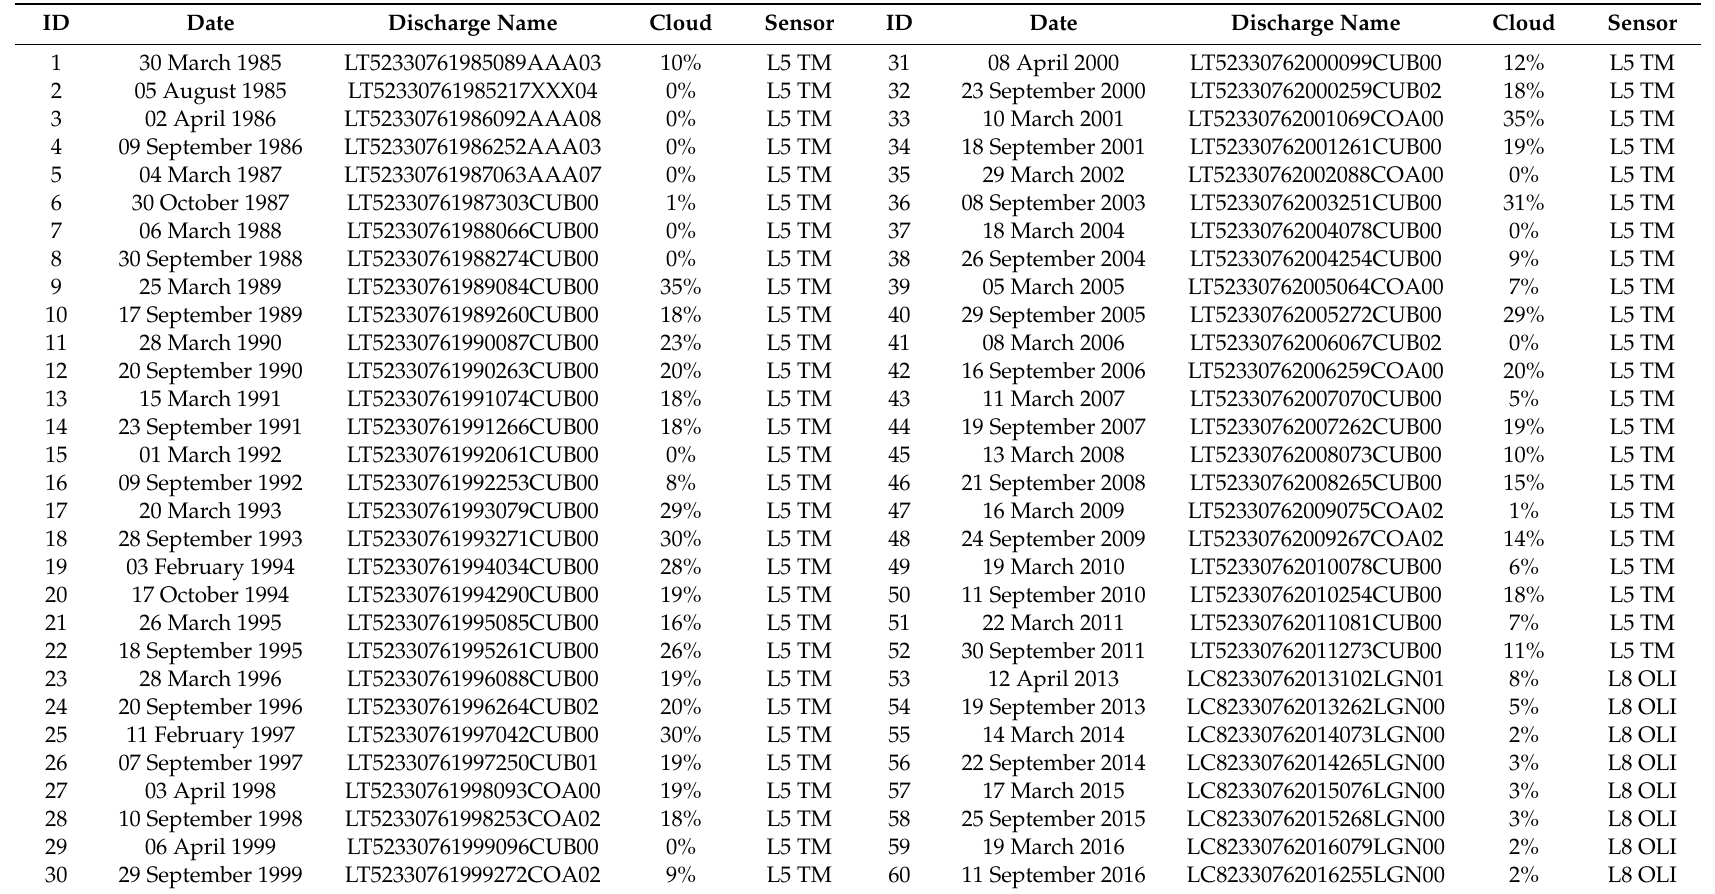
Table 1. Landsat Thematic Mapper (TM) and Operational Land Imager (OLI) images used in the